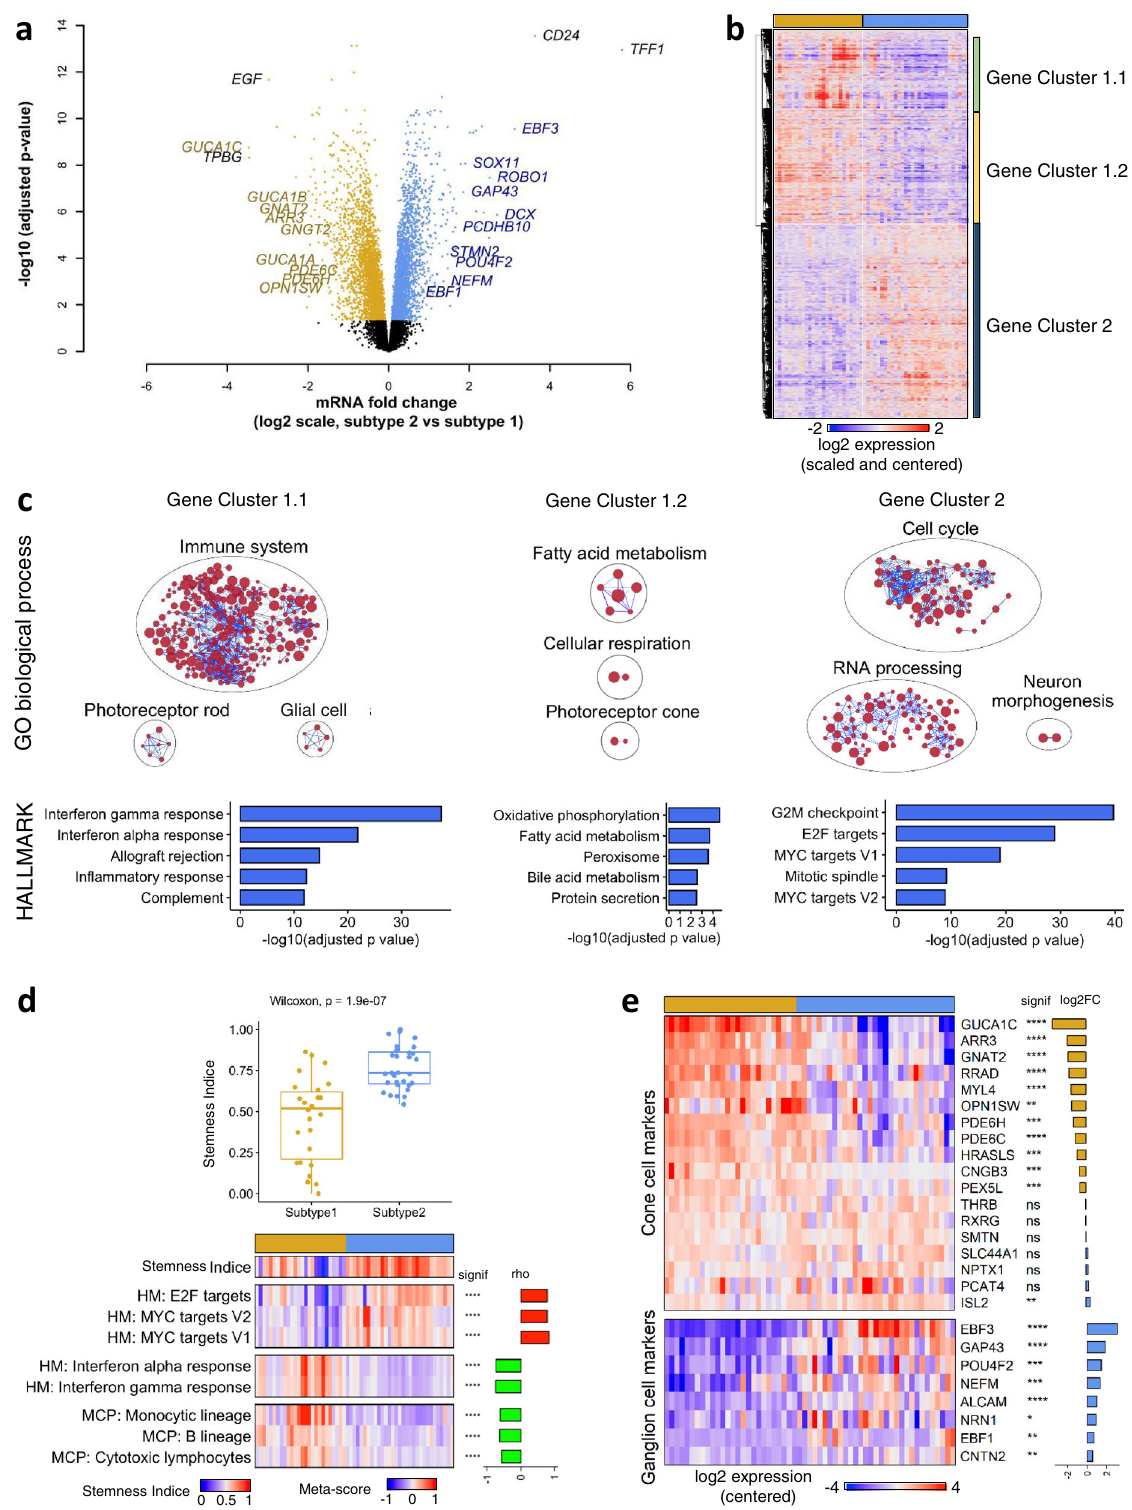
populations present in the tumor, we performed shared nearest neighbor (SNN) clustering and identi fi ed seven clusters (Fig. 5a). To characterize the different clusters, we used (1) known cell type-speci fi c markers, (2) cluster markers (the most upregulated genes in the cluster compared to all other clusters), (3) pathway analysis of cluster markers, (4) correlation to bulk mRNA expression pro fi les of puri fi ed cell types (Fig. 5b, c and